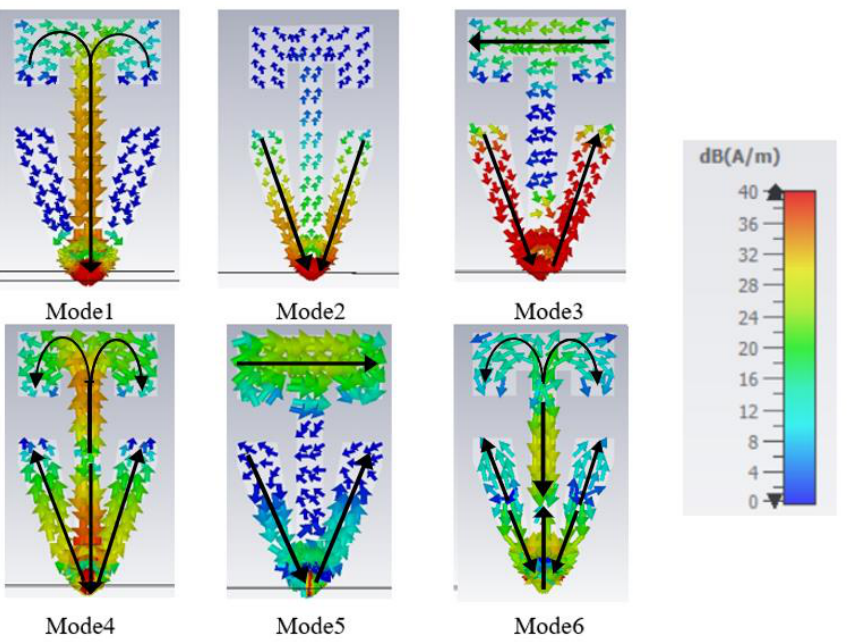
Figure 6. Modal current distribution at resonance frequencies for Mode 1 at 0.79 GHz, Mode 2 at 1.85 GHz, Mode 3 at 2.01 GHz, Mode 4 at 3.05 GHz, Mode 5 at 3.17 GHz, and Mode 6 at 5.47